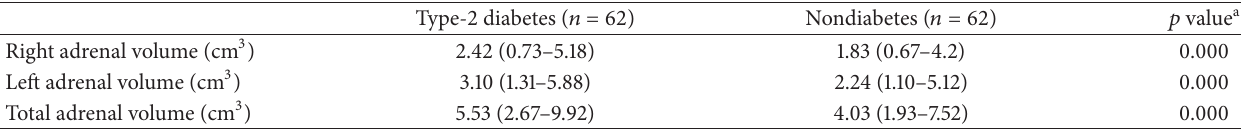
Table 3: Adrenal volumes in diabetic patients and control patients.